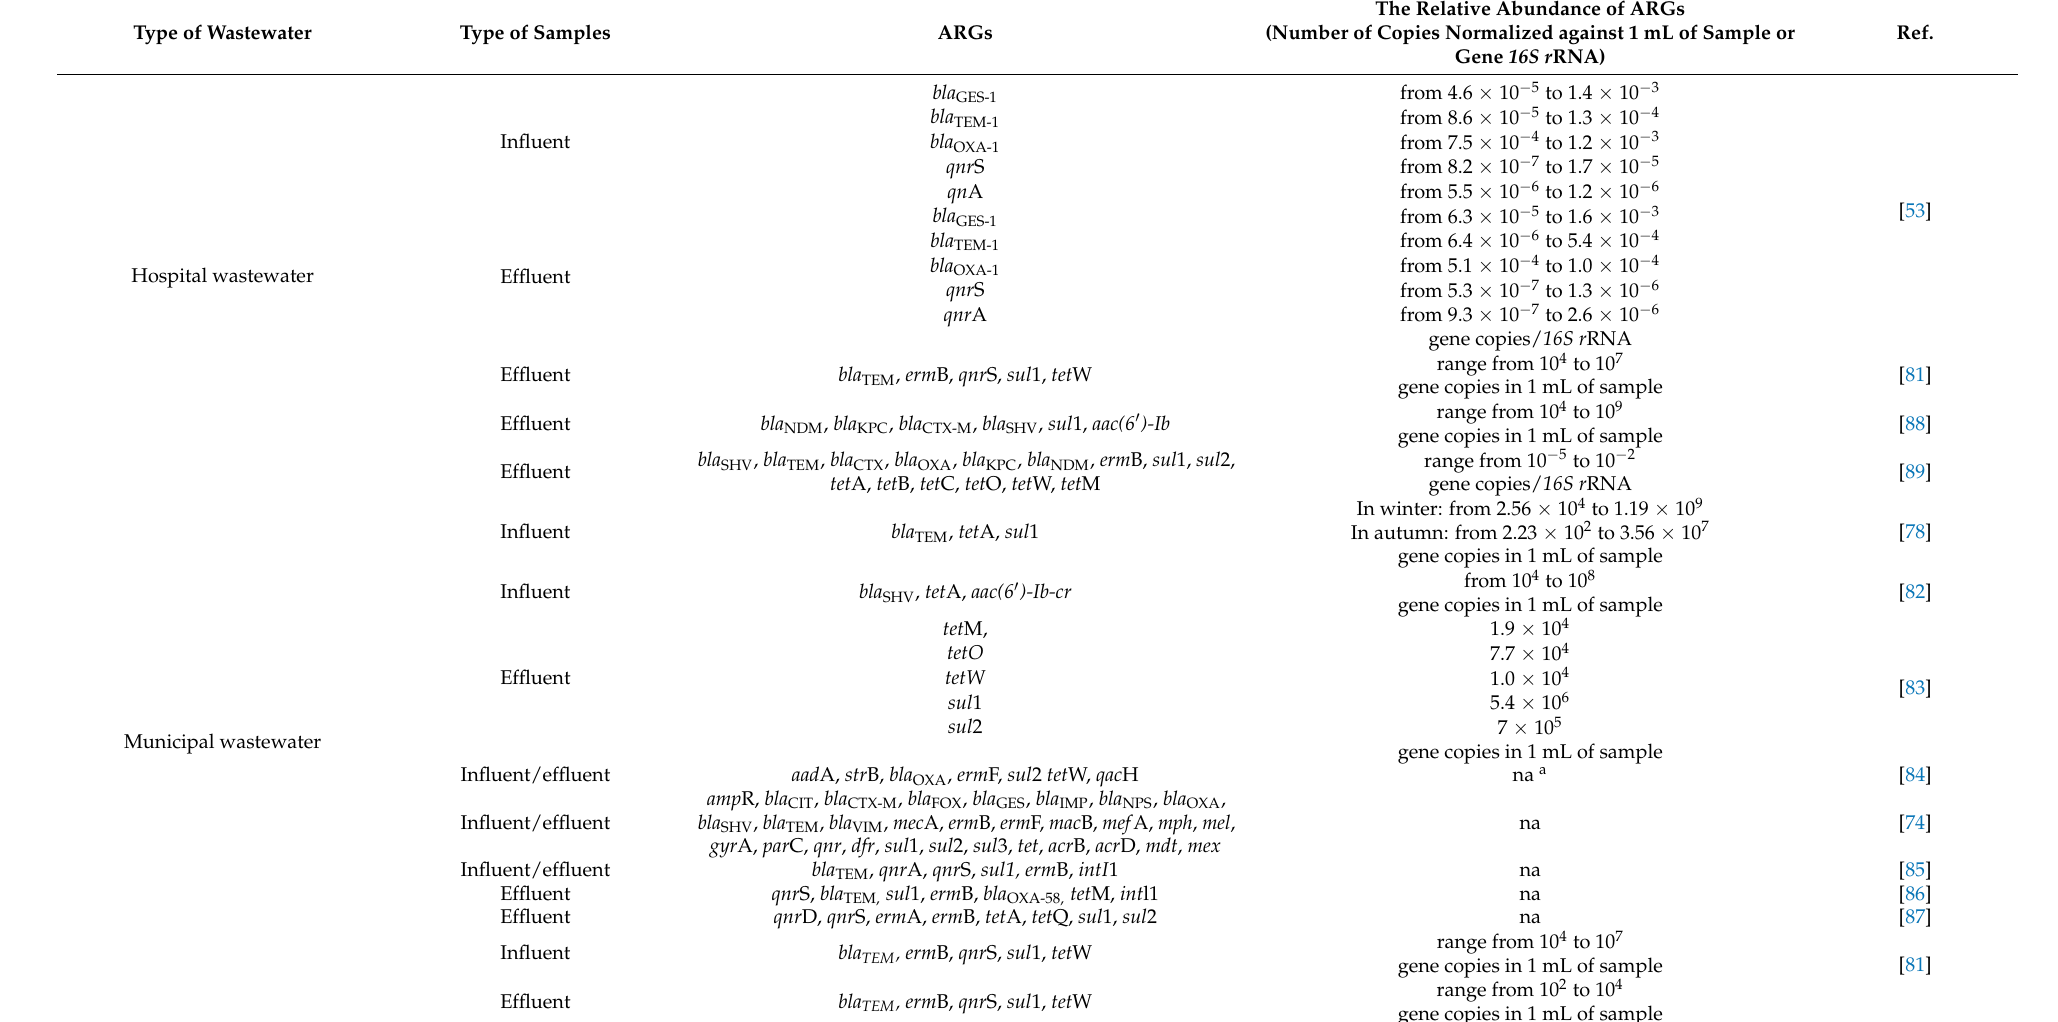
Table 3. Types of ARGs detected in the wastewater collected from